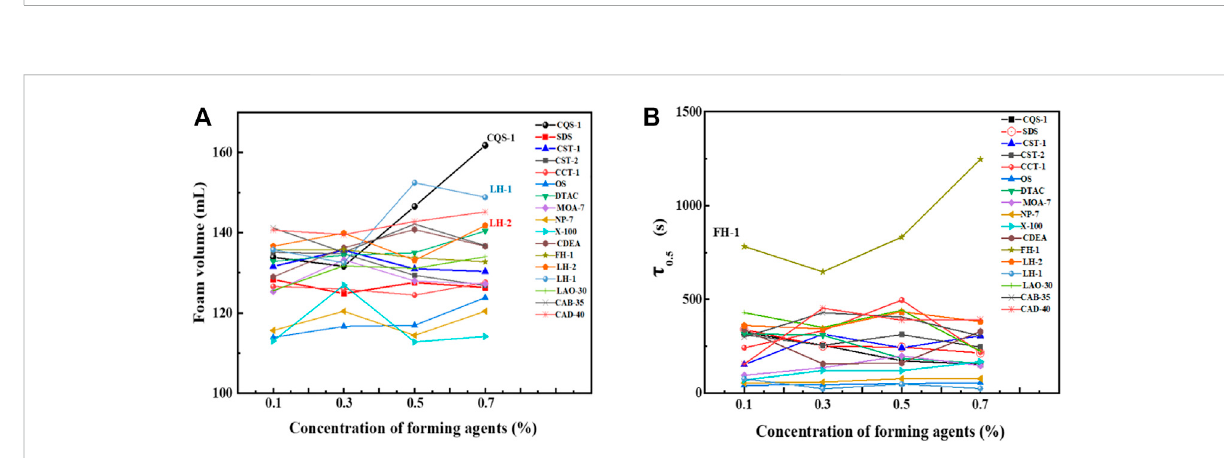
FIGURE 5 Effects of different thickening and stabilizing accelerator concentrations on the performance of the 1# foam system. (A) The foaming volume for different foam types with different concentrations. (B) The half-life of different foam types with different concentrations. (C) Comprehensive indices of different foam types with different